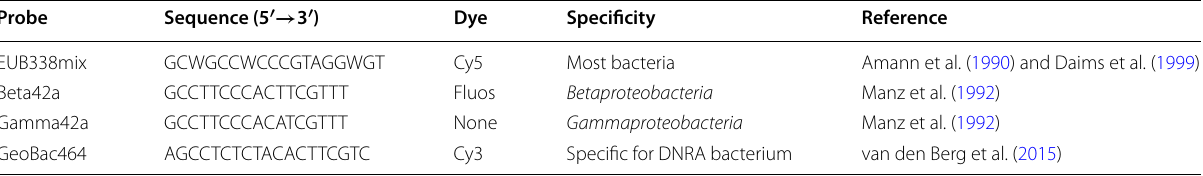
Table 2 Probes used in FISH analysis of the culture